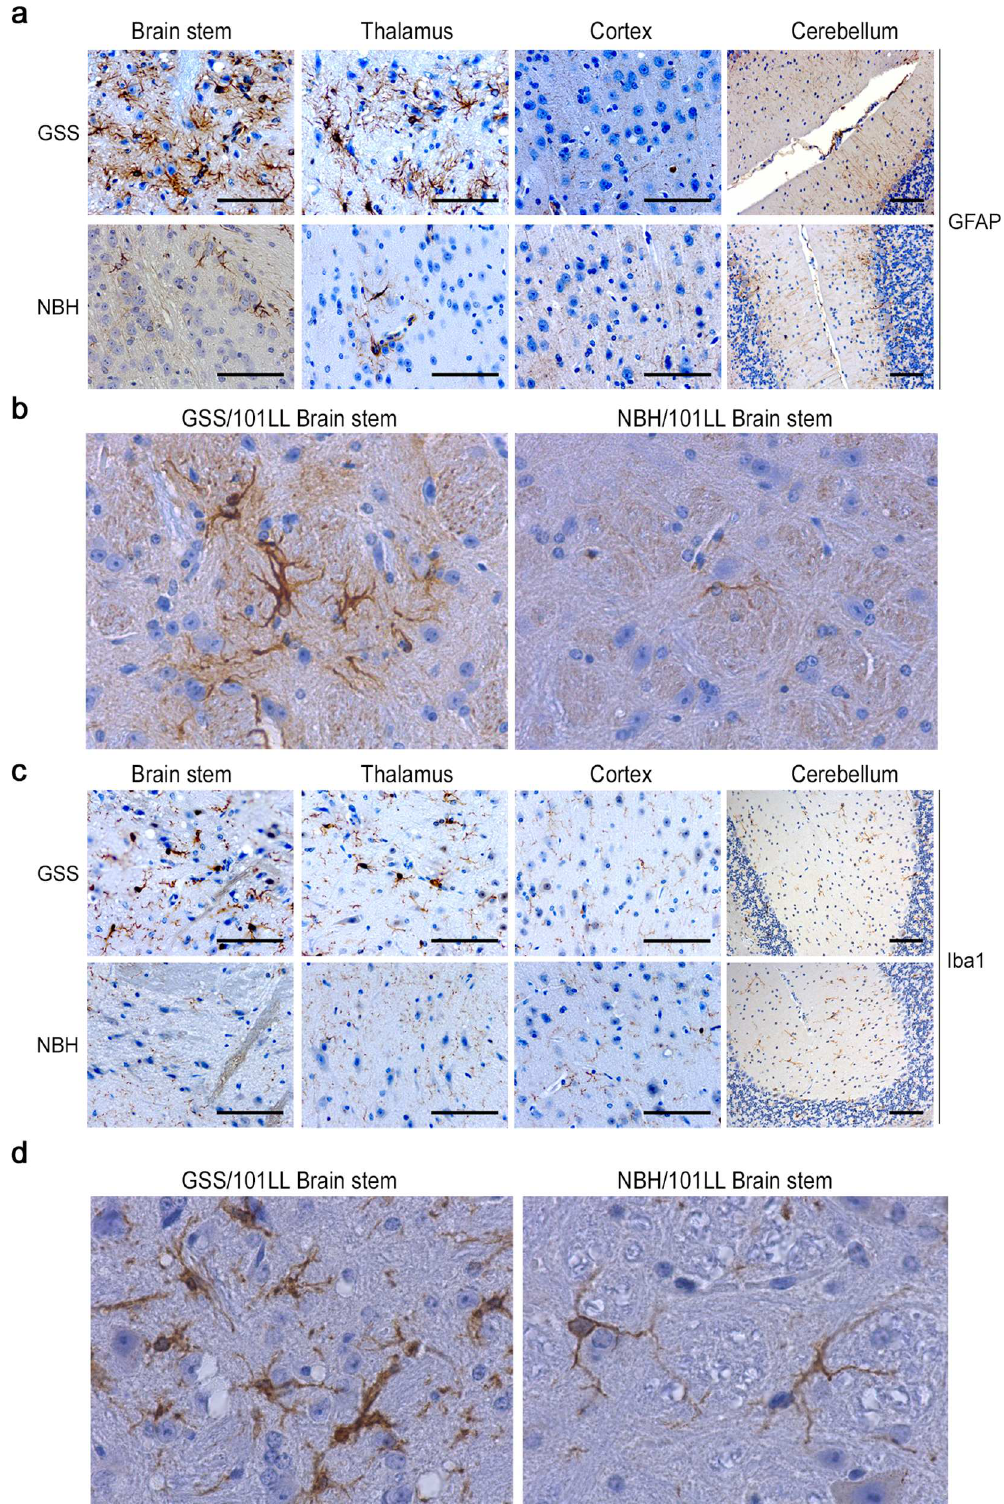
Fig 3. Morphological glial cell responses are restrictedto specific brain regions. (a) Severe astrogliosis is observedin the brain stem and thalamusof GSS/101LL but is not detected in NBH/101LL age-matched controls